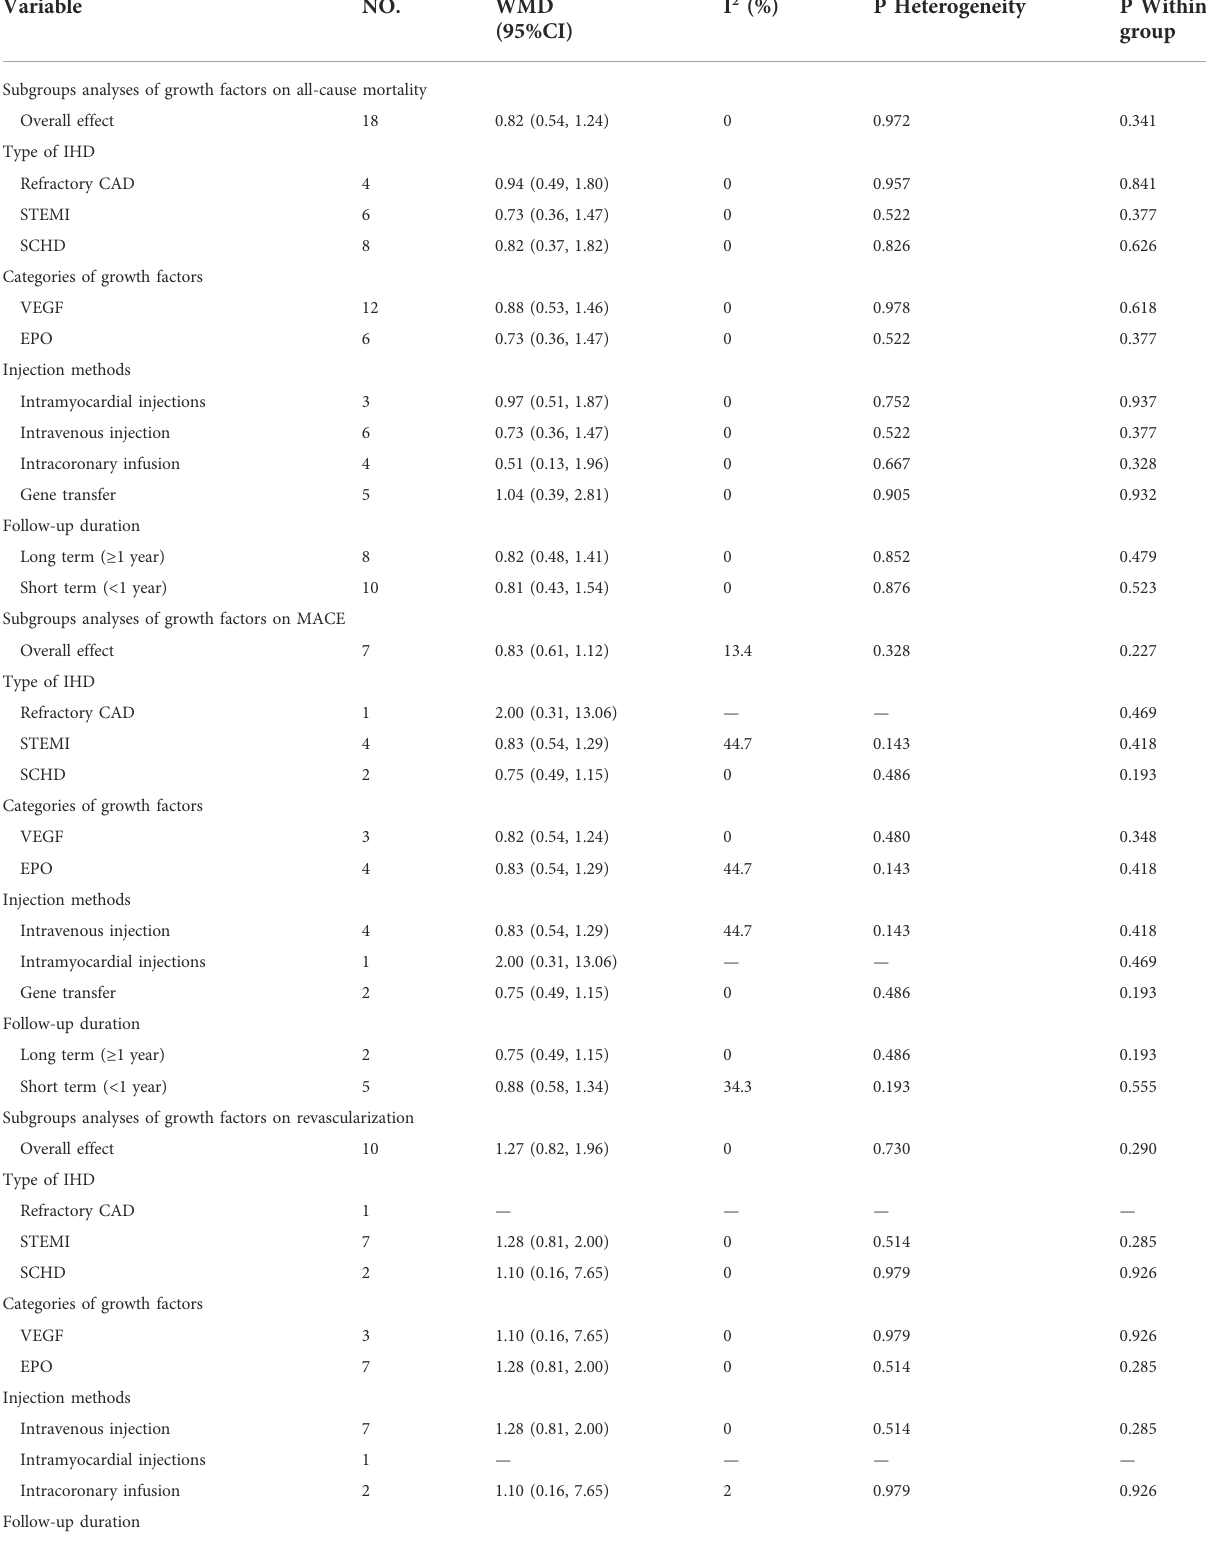
TABLE 2 Subgroup analyses of growth factors on